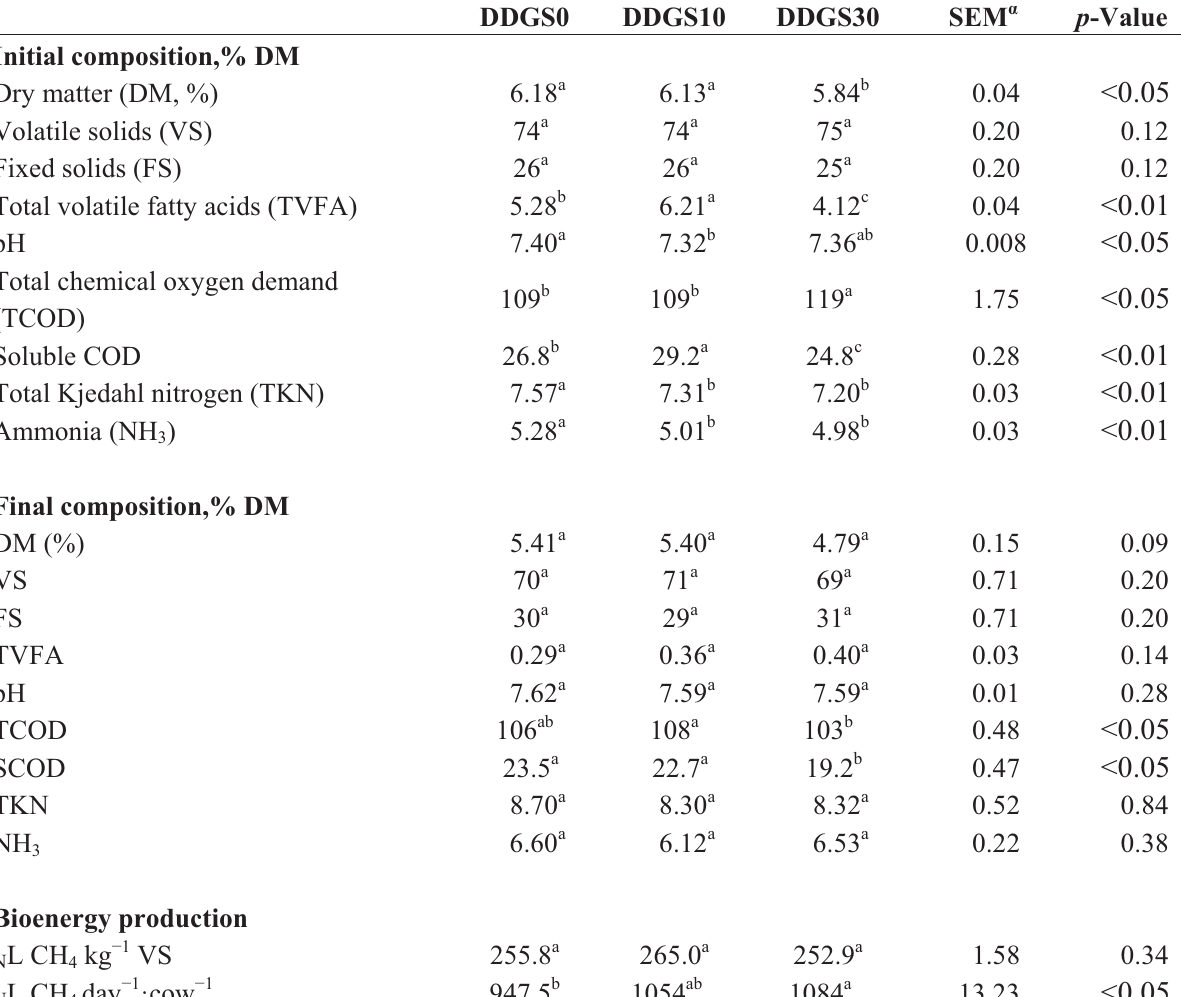
Table 3. Initial and final composition of slurry and CH production trial as a function of feeding strategy (inclusion of 0, 10%, 30% corn dried distillers grains with solubles – DDGS0, DDGS10 and